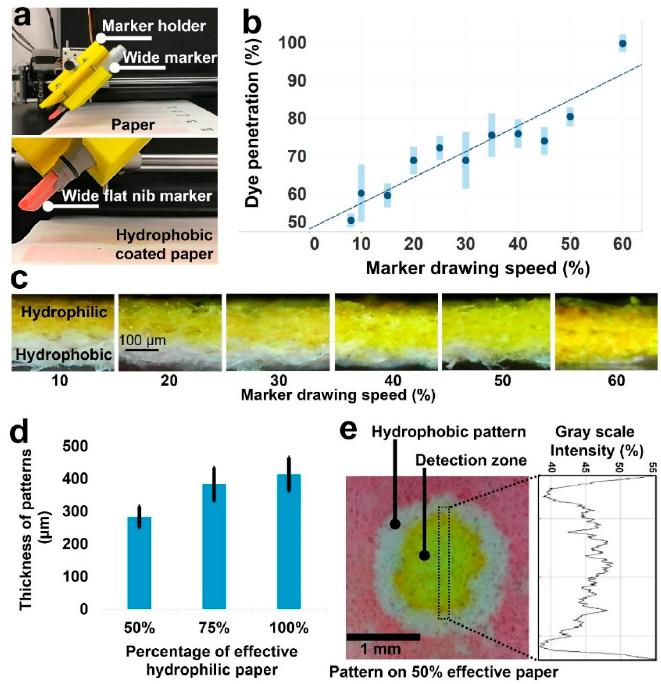
Figure 2. Evaluation of decreasing e ff ective paper thickness on the resolution of patterns. ( a ) The custom-designed wide marker holder connected to the pen plotter to deposit a layer of hydrophobic ink on the chromatography paper. ( b ) Graph of percentage of food dye penetration through the thickness of paper (indicating the e ff ective hydrophilic thickness of paper) versus the plotting speed percentage used to plot hydrophobic solution on the backside of chromatography paper. ( c ) Images of chromatography paper cross-sections after being coated with hydrophobic solution using the wide marker plotted for various speeds. The yellow food dye is applied to the hydrophilic side of paper to distinguish it from the hydrophobic side of paper. ( d ) Graph of line thickness of patterns on the chromatography paper with 50%, 75%, and 100% e ff ective thickness ( N = 6 and the error bar shows the standard deviation). ( e ) Image of a circular pattern (2 mm diameter) on the chromatography paper with 50% e ff ective thickness and grayscale intensity analysis of food dye in detection